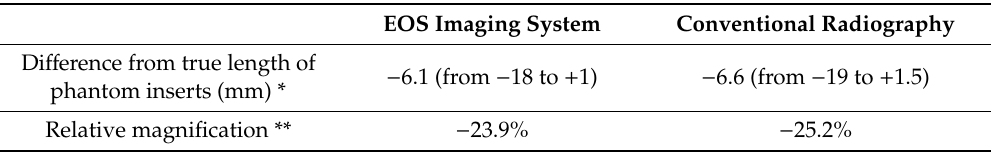
Table 1. Insert length measurements with EOS and CR.